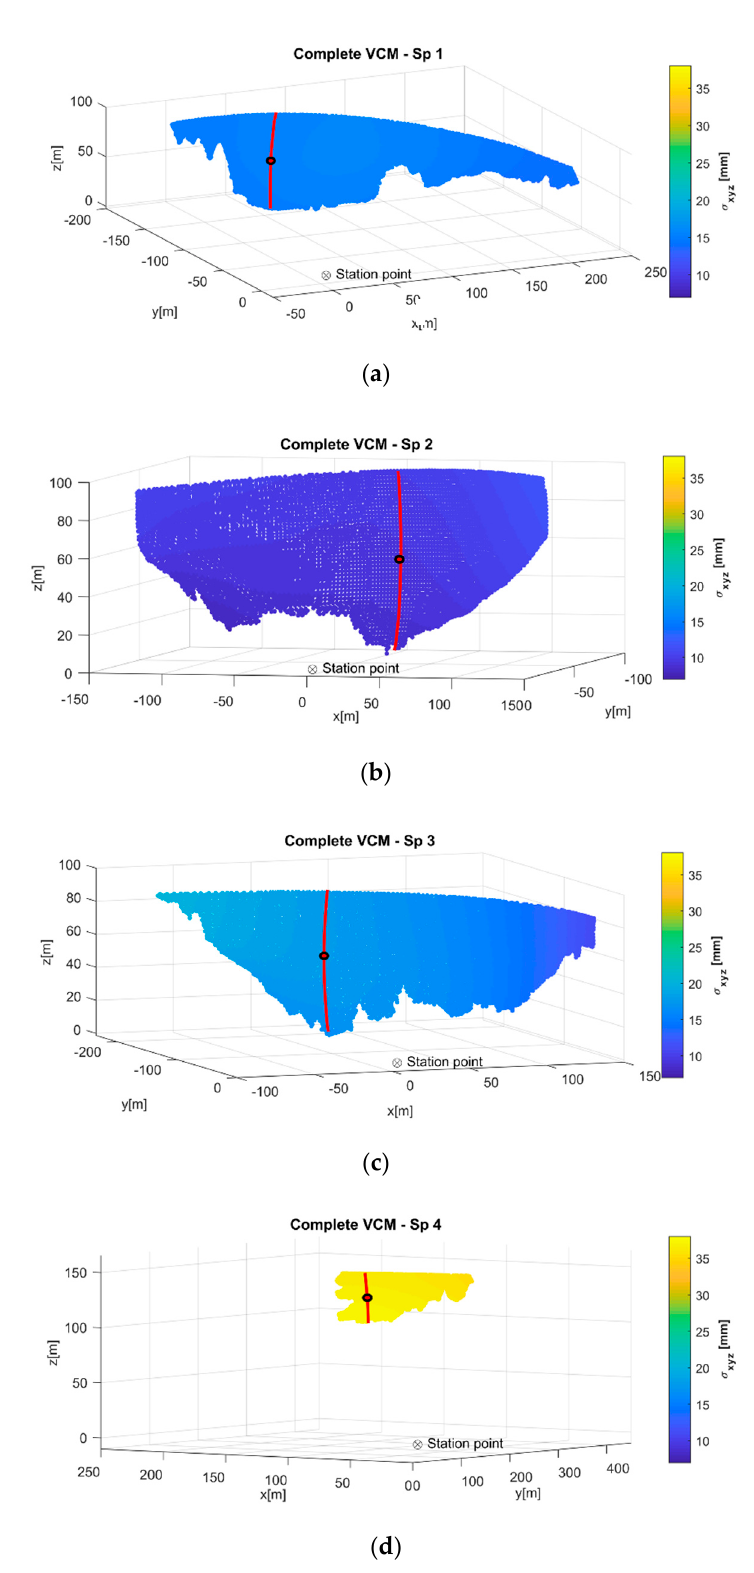
Figure 6. Example of error of position distribution on point clouds, selected vertical sections (red lines) and selected points (red circles). Scanning station points are (a) S1, (b) S2, (c) S3, (d) S4.